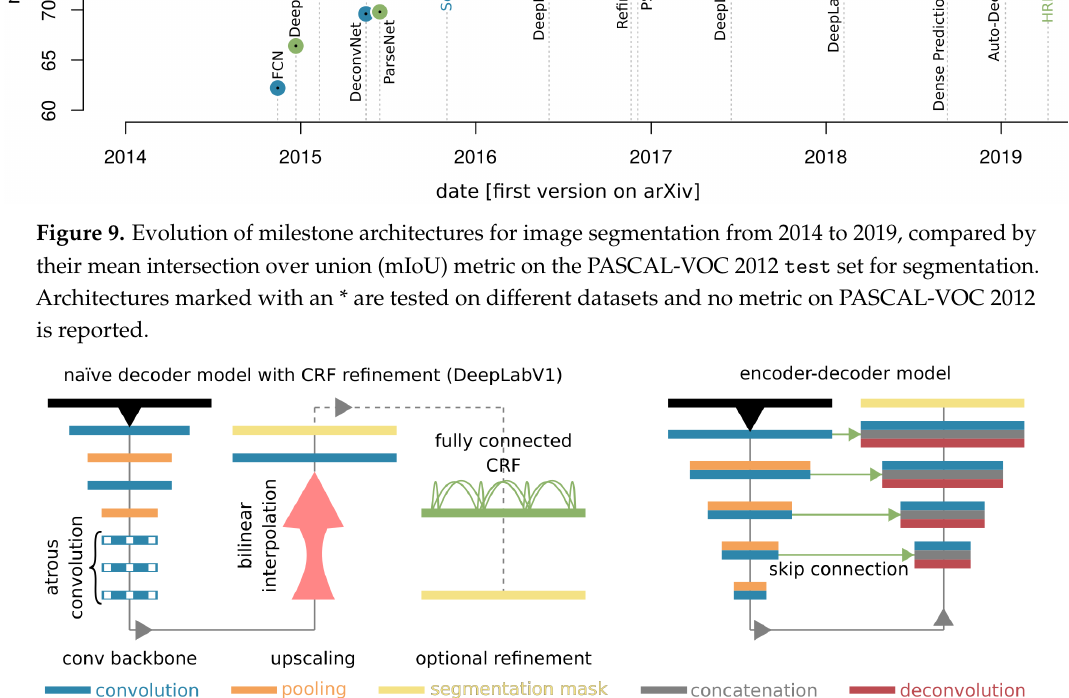
Figure 10. Conceptual overview of naïve decoder ( left ) and encoder–decoder design ( right ). As an example for the naïve decoder design, DeepLabV1 was chosen, which uses atrous convolution as the last layers in the backbone, bilinear interpolation as upscaling method and a fully connected conditional random field (CRF) module for refinement [56]. As example for the encoder–decoder models, an U-Net inspired design shows the skip connections, transporting feature maps from the encoder path to the corresponding decoder path, providing increasingly precise feature localisation during upscaling